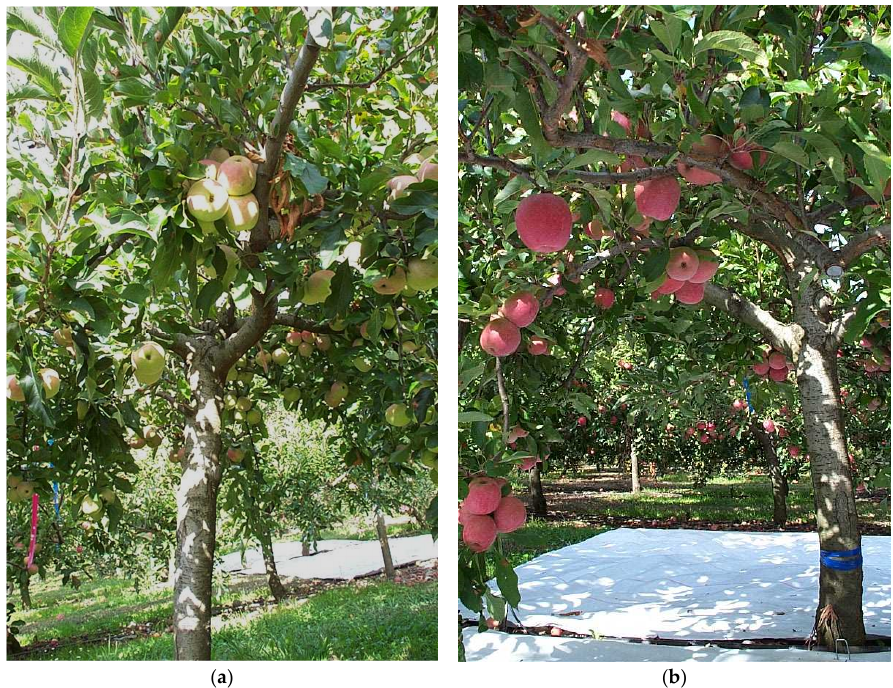
Figure 1. Apple trees of cv. Pacific Rose on MM 106 ( a ) without (left) and ( b ) with reflective mulch (right) at HortResearch, Motueka (NZ).